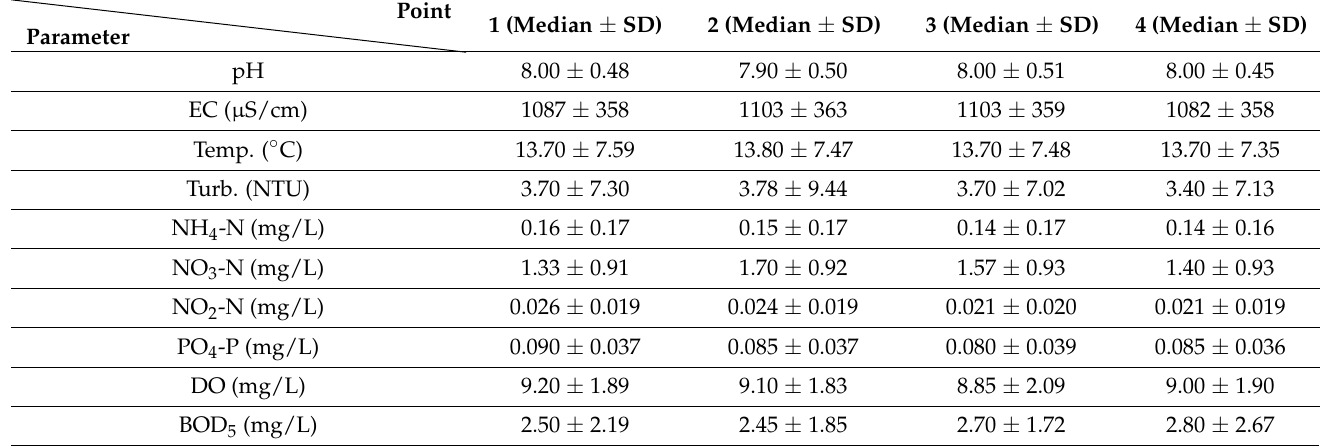
Table 7. Descriptive statistics at analyzed research points.